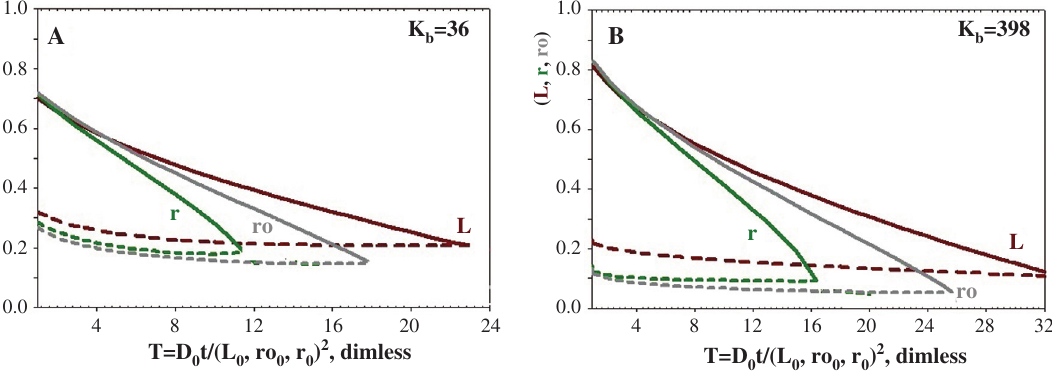
r , ro,L (T), (solids); Disp 5 R = 0.01; D = 0.0085; D = 0.03. Kb = 36 (A); 398 (B). T fin (A) < T fin 1SO4 3HSO4 4H